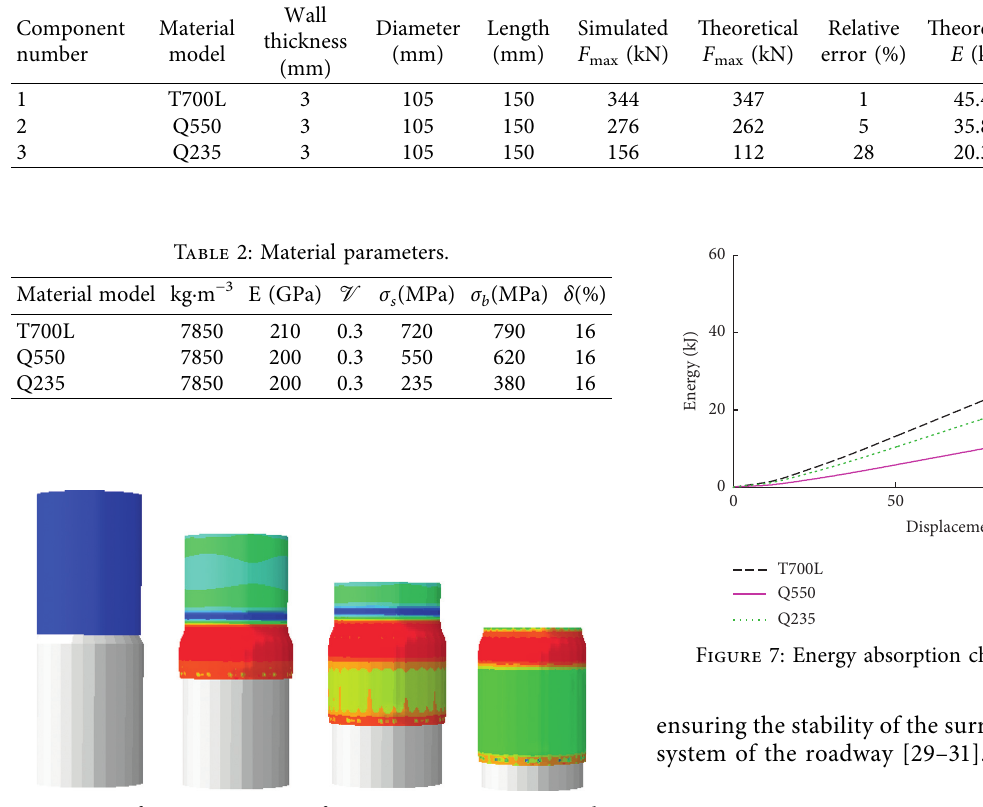
Table 1: Dimensions and anti-shock characteristics of thin-walled round pipes.